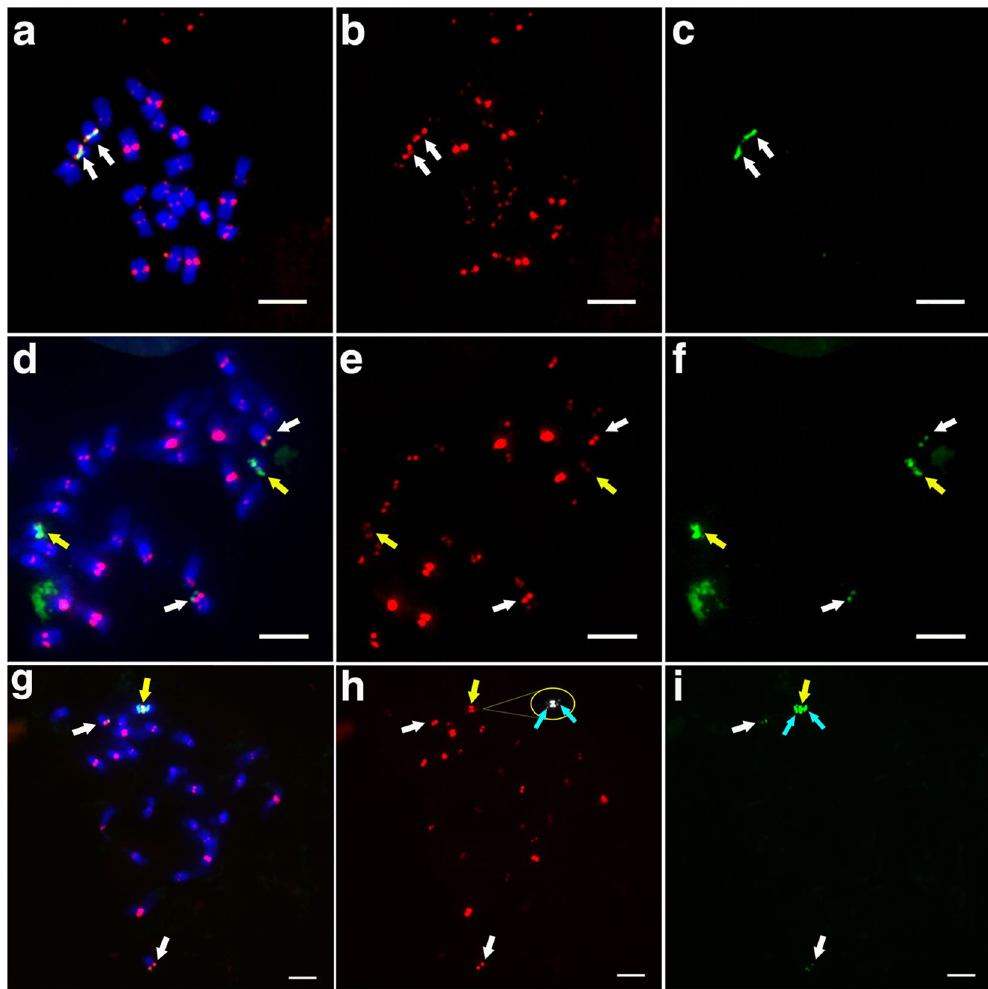
Figure 2. FISH analysis of rice line Zhongxian 3037 and variant YZG-5. Chromosomes were counterstained with DAPI. Red indicates CentO signals, green indicates 5S rDNA signals. Scale bars represent 5 μ m in all images. ( a – c ) Normal chromosome 11 in line 3037, with two pairs of CentO and 5S rDNA signals. ( d – f ) Line T0135, with two pairs of telocentric chromosome 11. White arrows show 11L∙ with weaker 5S rDNA signals and stronger CentO signals, and yellow arrows show 11S· with stronger 5S rDNA signals and weaker CentO signals. ( g – i ) Variant YZG-5, with a structurally tricentric chromosome and two telocentric chromosomes derived from Chr11. White arrows show 11L∙ with weaker 5S rDNA signals and stronger CentO signals. In figure h , yellow and cyan arrow indicate 11S∙11S∙11S∙11S with one stronger CentO signal located at the middle region and two weaker CentO signals, respectively. In figure i , yellow and cyan arrows indicate 11S∙11S∙11S∙11S with three stronger 5S rDNA